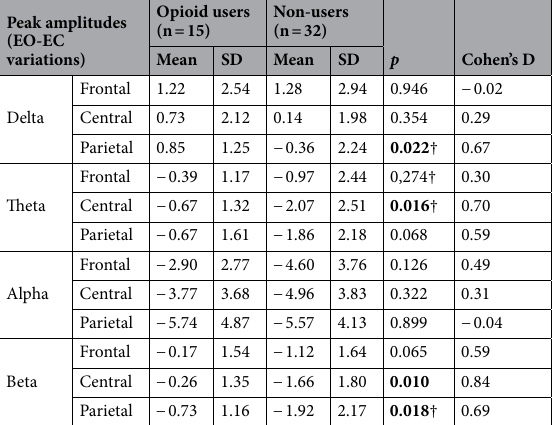
Table 3. Comparisons of peak amplitudes (variations between EO-EC states) for each ROI according to opioid users and non-users groups (total n = 47). Bold values indicates statistically significant differences (P < 0.05). P-values are based on Independent Student t -tests, except for † which are based on Welch test due to heterogeneity of variance tested with Levene’s test. Effect sizes are based on Cohen’s D. ROI = region of interest; EO = eyes open; EC = eyes closed; SD = standard deviation.